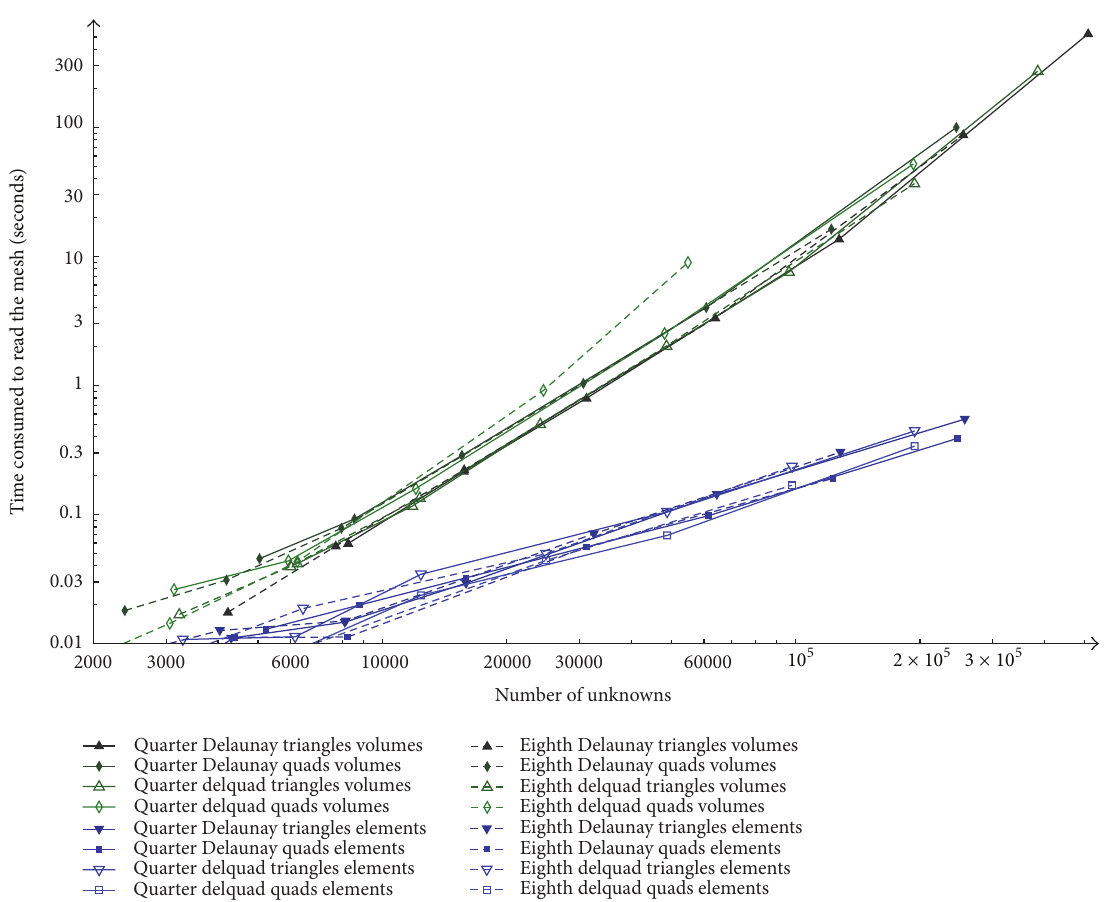
Figure 22: Time needed to read the mesh versus number of